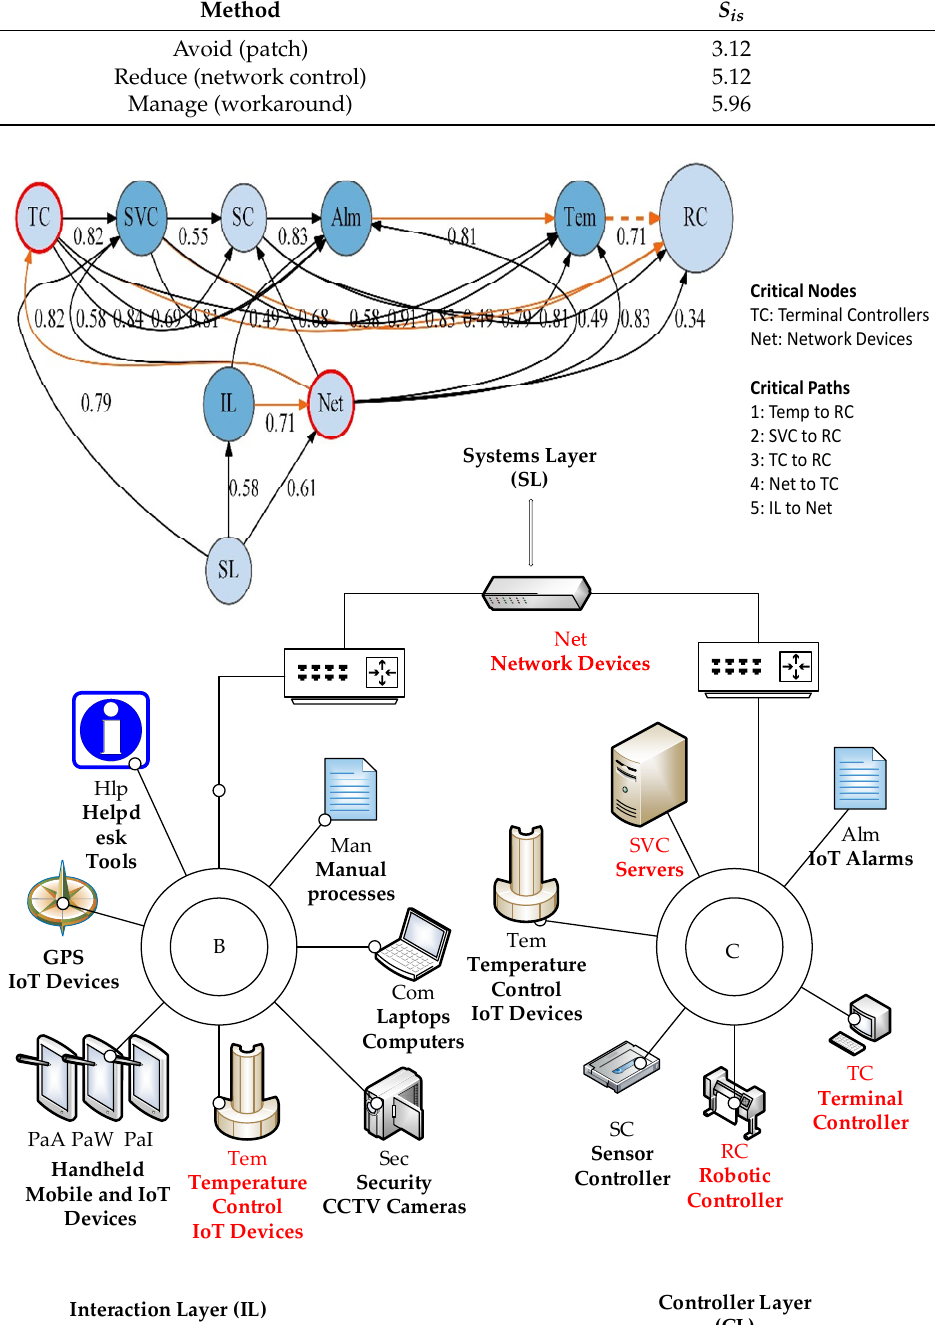
Figure 5. Critical nodes and paths for the supply chain hybrid network.